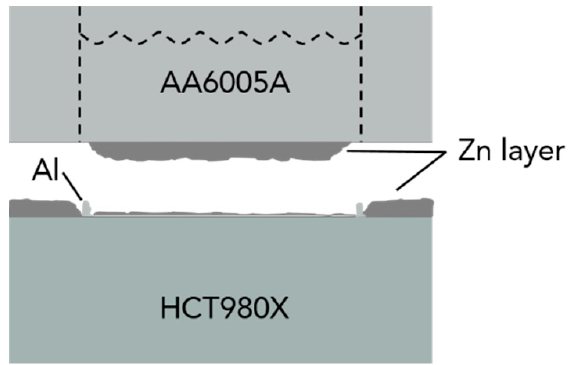
Figure 9. Superimposed SEM/EDX maps of the fractured surfaces after tensile shear tests for the parallel configuration (white circles mark an improved Al concentration).